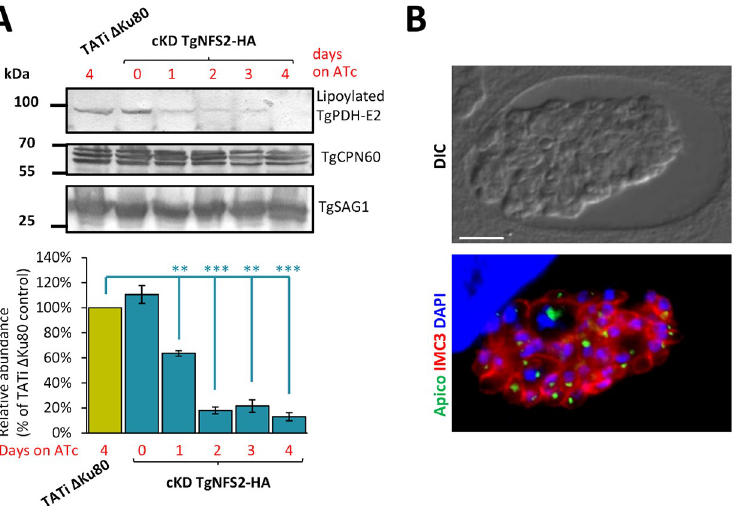
Fig 7. TgNFS2 depletion impacts apicoplast-related pathways and has deleterious effects on parasite replication. A) A decrease in the lipoylation of the E2 subunit of pyruvate dehydrogenase (TgPDH-E2), which depends on the Fe- S-containing lipoyl synthase called LipA in the apicoplast, was observed by immunoblot using an anti-lipoic acid antibody on cell extracts from cKD TgNFS2-HA parasites kept with ATc for an increasing period of time. TgCPN60 was used as a control for apicoplast integrity. TgSAG1 was used as a loading control. Decrease of lipoylated TgPDH-E2 was quantified by band densitometry and normalized with the internal loading control. Data represented are mean ± SEM of n = 3 independent experiments. �� p � 0.01, ��� p � 0.001 ANOVA comparison. B) cKD TgNFS2-HA parasites that were grown in the presence of ATc for 5 days were co-stained with anti-TgIMC3 (to outline parasites and internal buds) and anti-CPN60 (an apicoplast marker), which highlighted abnormal membrane structures and organelle segregation problems. Scale bar represents 5 μ m. DNA was labelled with DAPI. DIC: differential interference